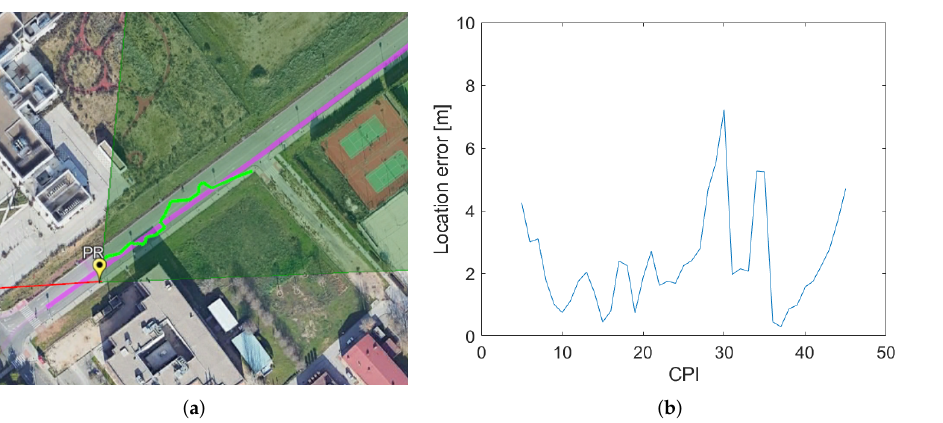
Figure 13. Localization results for a cooperative target: ( a ) Google Earth view of the cooperative target’s estimated position (green) versus target GPS data (purple); ( b ) Estimated localization error for the cooperative